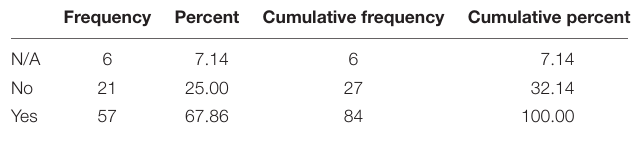
TABLE 1 | Perceived need for smart personal